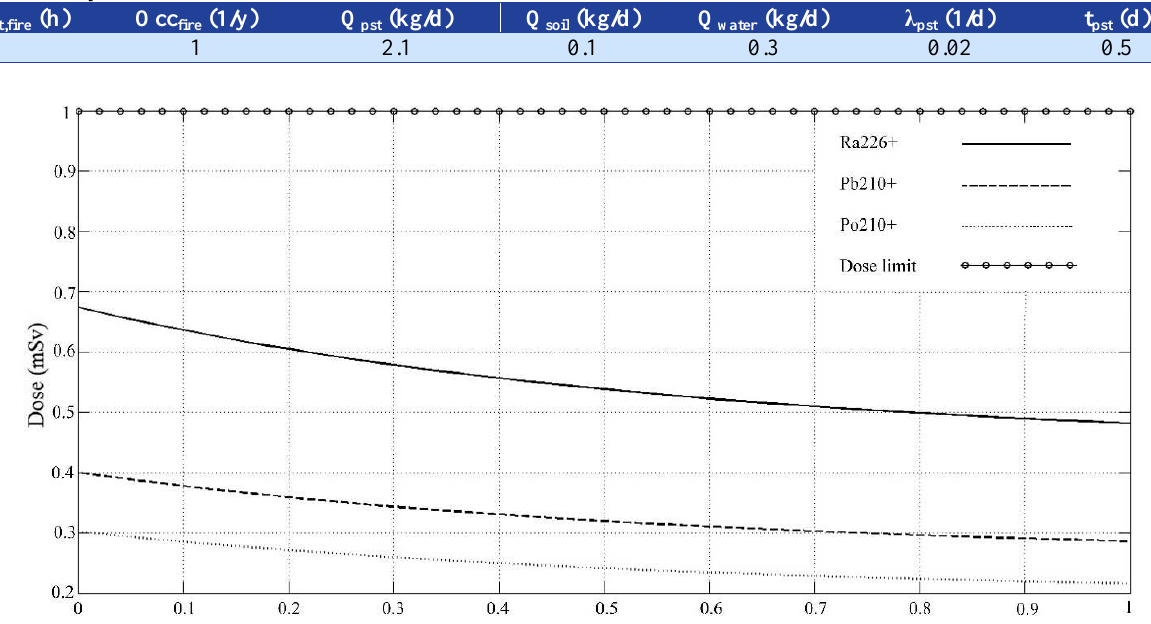
Figure 2. Dose assessment results for the chinkaras